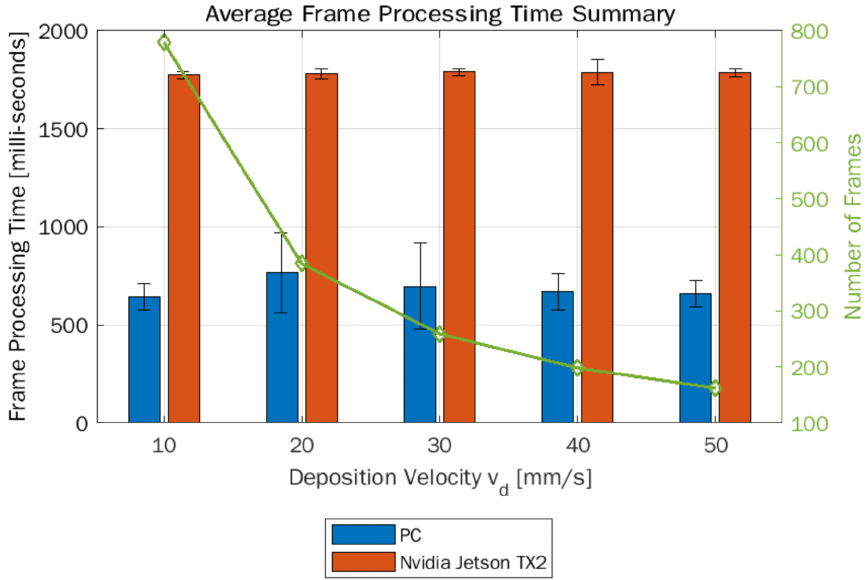
Figure 12. Summary of frame processing time (FPT) for in-situ extrusion width